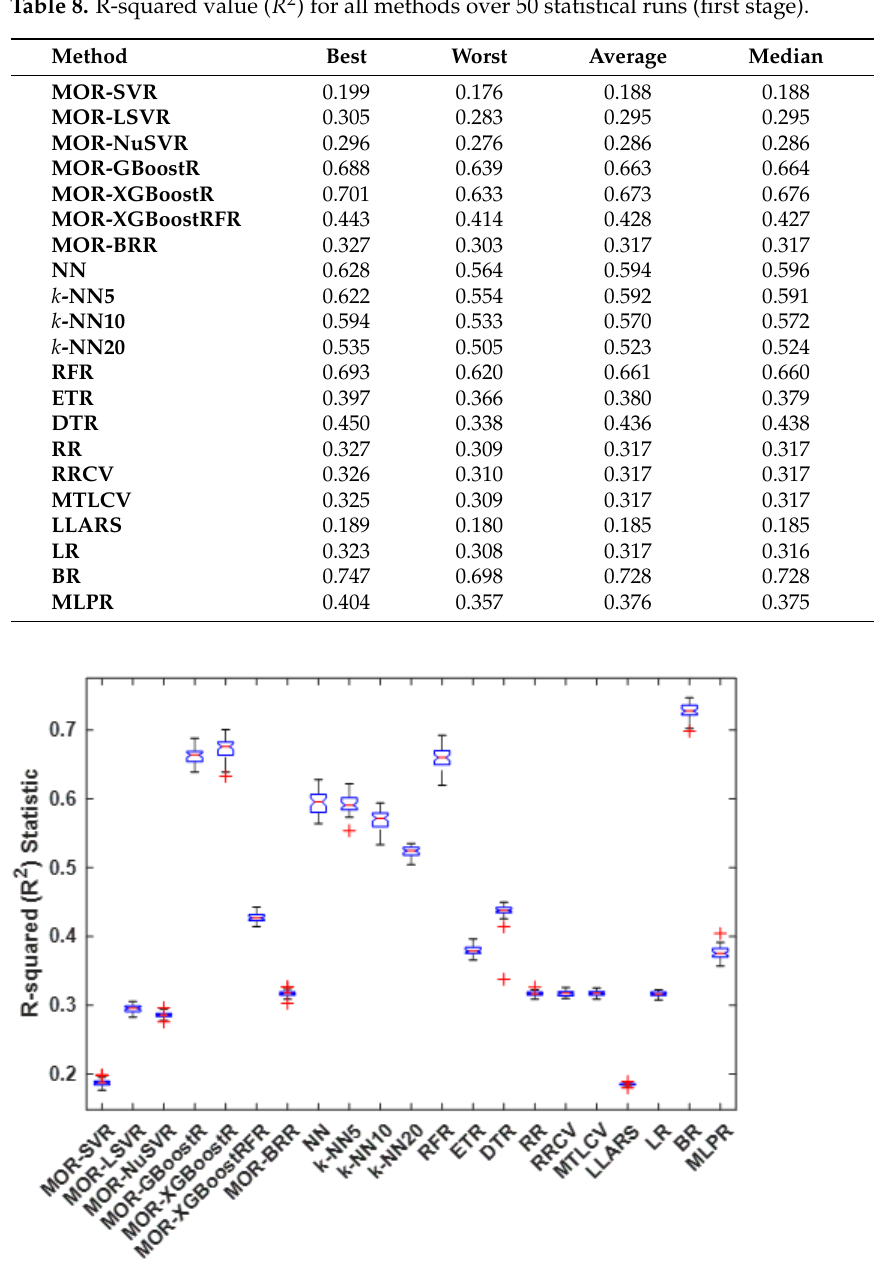
Table 8. R-squared value ( R 2 ) for all methods over 50 statistical runs (first stage).